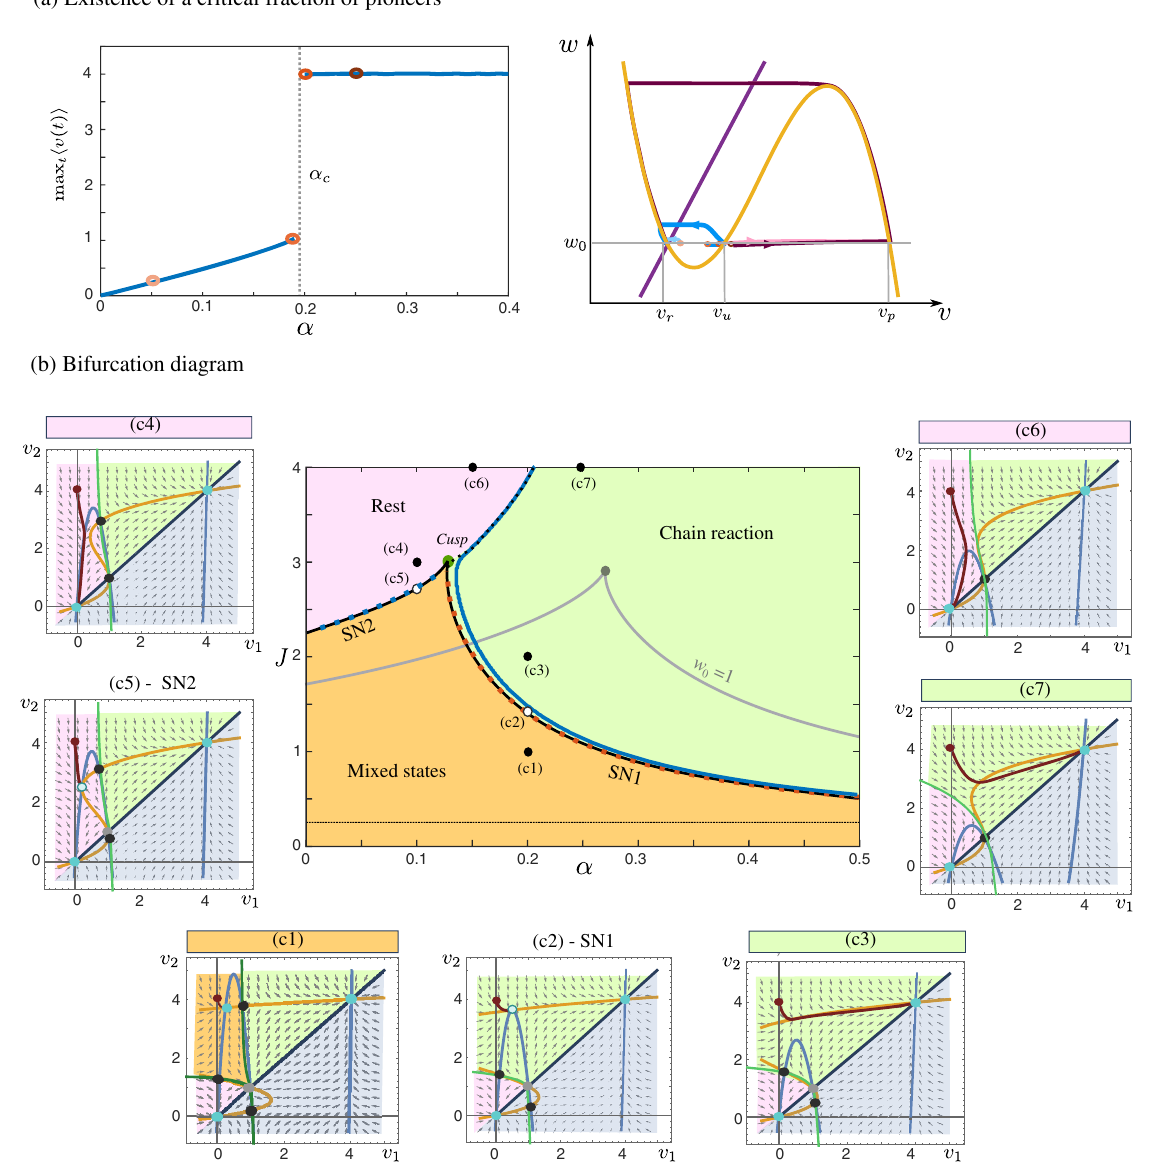
FIG. 2. Chain reaction. (a) Left: Maximal value of the average voltage for network [Eq. (1)] in the absence of noise ( σ ¼ 0 ) as a function of the initial proportion of pioneers α ( n ¼ 1000 , a ¼ 4 , ε ¼ 0 . 01 , b ¼ 4 , J ¼ 1 . 5 , I ¼ 0 ) shows a sudden discontinuity at a critical value α , where (right) trajectories in the phase plane (yellow, v nullcline; purple, w nullcline) switch from rapid returns to c rest for α < α (light blue, α ¼ 0 . 05 ; blue, α ¼ 0 . 19 ; lighter two shades of red circles in the right-hand diagram) to long collective c spiking excursions for α > α (pink, α ¼ 0 . 21 ; red, α ¼ 0 . 25 ; darker two shades of red circles in the right-hand panel). Initial c condition (averaged) is depicted by a colored circle. Gray line, w 0 , depends on the level of noise; the values v intersections of the line w ¼ w 0 and the cubic nullcline. (B) Critical fraction of pioneers associated with the chain reaction as a function of coupling J in the two-dimensional system [Eq. (1)] (blue curve) or in the simplified equation (2) (dashed blue, transition from rest to mixed equilibria; dashed red, transition from mixed equilibria to pioneers; dotted black, transition from rest to pioneer), together with the bifurcations of the simplified one-dimensional model (2) with w 0 ¼ 0 (black) or w 0 ¼ 1 (gray), showing two saddle-node bifurcations curves (SN1 and SN2) joined at a cusp bifurcation. (c1) – (c5) Typical phase portraits of the simplified system [Eq. (2)]. Dark blue, identity line (irrelevant phase space grayed); yellow and blue curves, v 1 and v 2 nullclines; cyan circles, stable fixed points; gray circles, unstable fixed points; black circles, saddles. Green lines represent the stable manifold of the saddles and partition the phase space into the attraction basin of stable fixed points [green, chain reaction; orange, mixed equilibrium; pink, rest, as in (c)]. Arrows represent the direction of the flow. The dark red curve represents the trajectory starting from v 1 ¼ v v 2 ¼ v . (c1) α ¼ 0 . 2 and J ¼ 1 , (c2) α ¼ 0 . 2 and J ¼ 1 . 4 near SN1, (c3) α ¼ 0 . 2 and J ¼ 2 , (c4) α ¼ 0 . 1 and J ¼ 3 , (c5) α ¼ 0 . 1 p and J ¼ 2 . 73 near SN2, (c6) J ¼ 4 and α ¼ 0 . 15 , (c7) J ¼ 4 and α ¼ 0 . 25